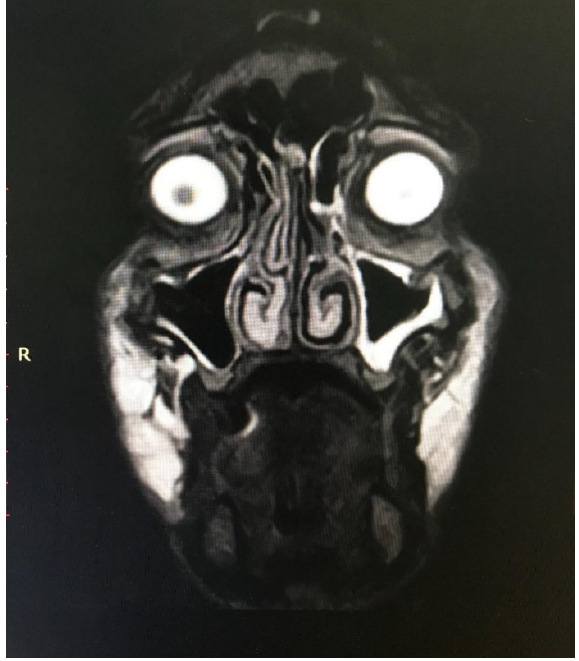
Figure 10. MRI of Caucasian male patient from Figure 8 showing bilateral collection of semi-fluid material.